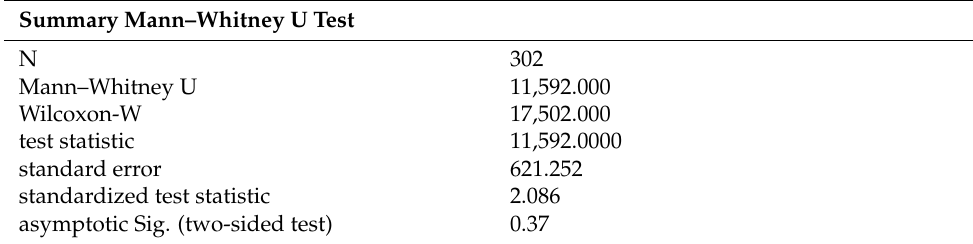
Figure 3. Kolmogorov-Smirnov norm test H6. Table 8. Mann–Whitney U test H6.